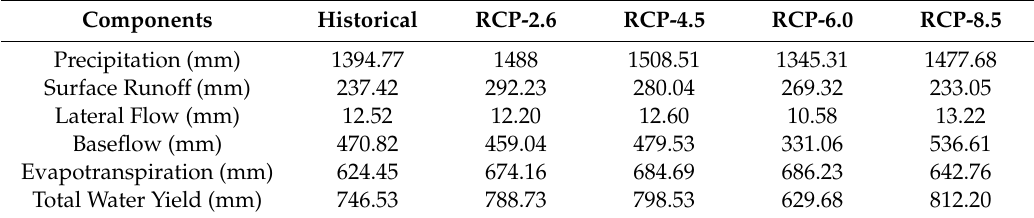
Figure 8. Annual water yield for the entire watershed.